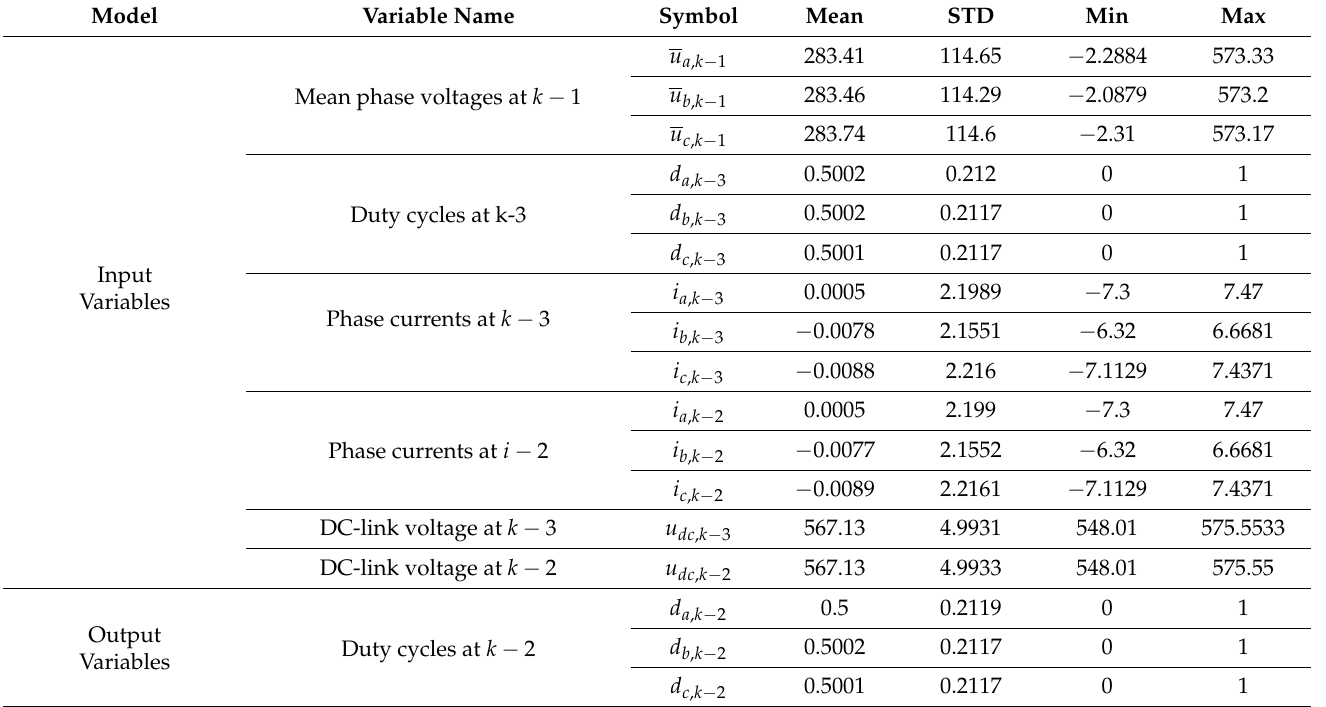
Table 2. Statistical description of the black-box inverter compensation scheme.(The k refers to sampling